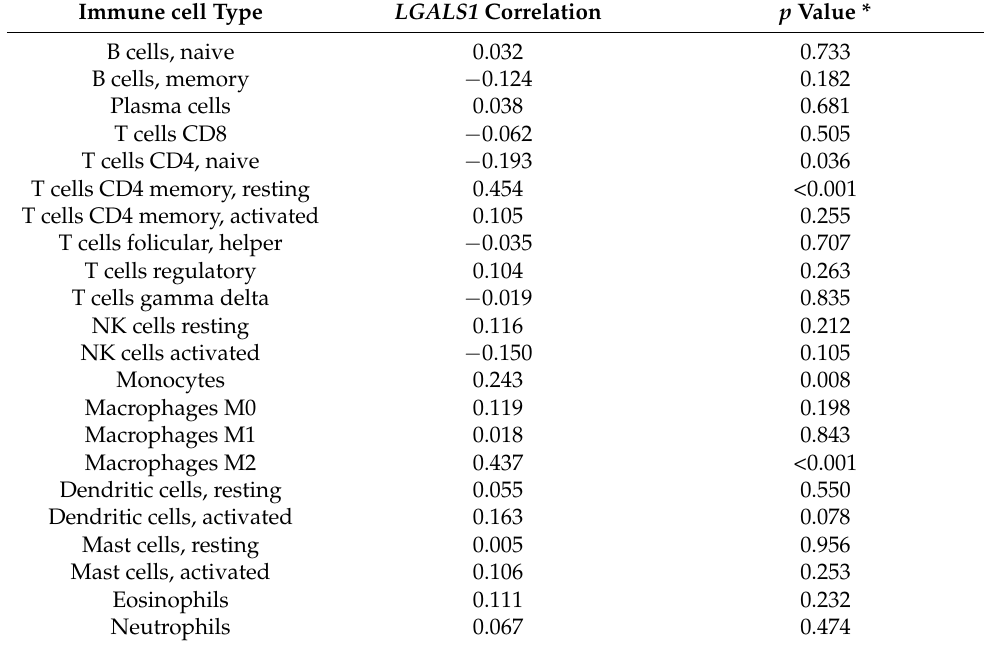
Table 5. Correlation (Pearson’s r) between LGALS1 expression and the CIBERSORT LM22 immune signature. LGALS1 RNA-seq gene expression levels were correlated with each of the 22 immune cell types generated by CIBERSORT deconvolution, showing a statistically significant positive correlation with tumors enriched in resting memory T cells, monocytes, and M2 macrophages and a statistically significant negative correlation with naïve T